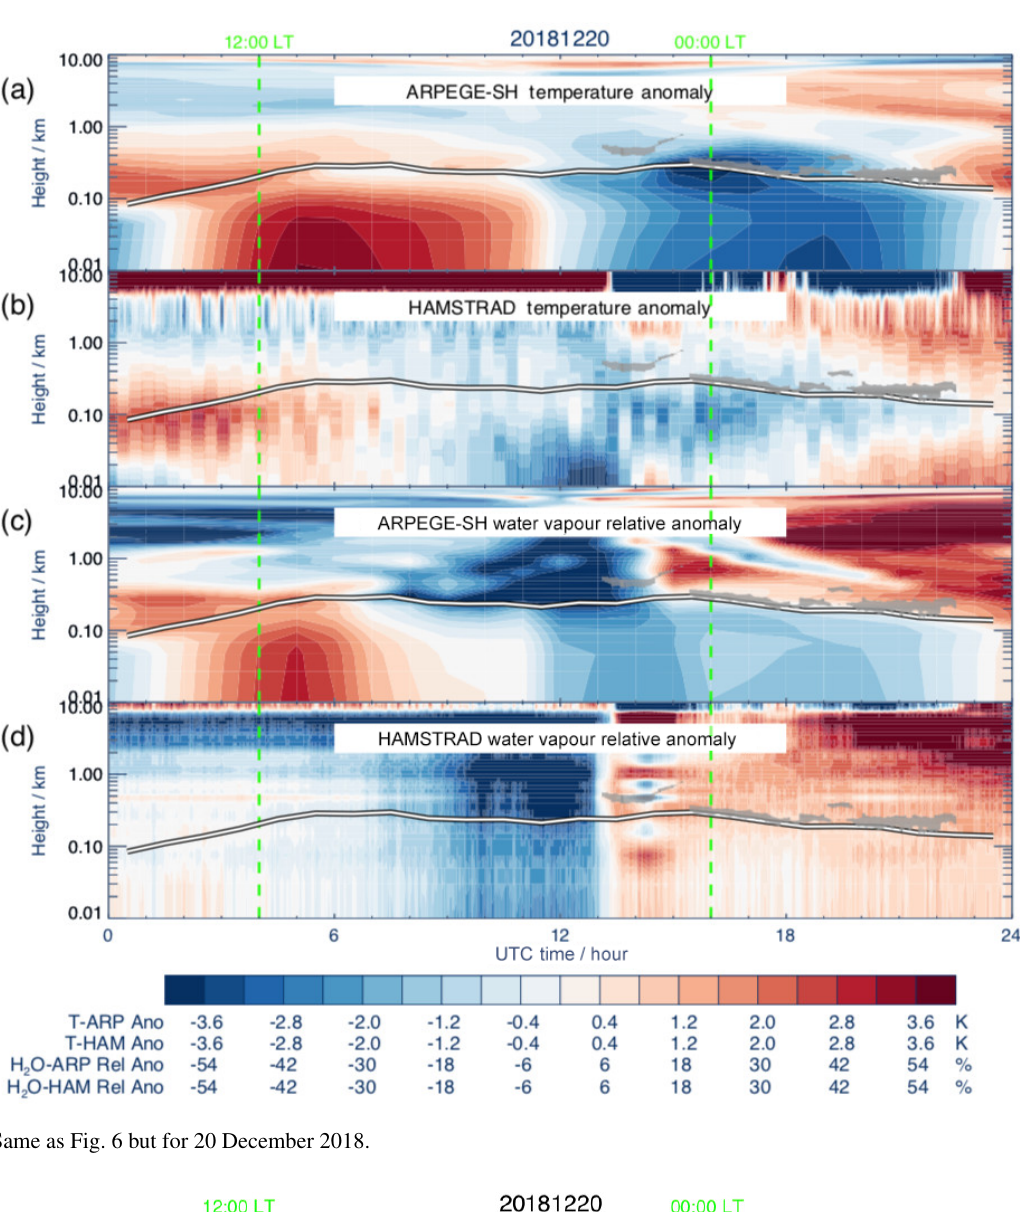
Figure 12. Same as Fig. 6 but for 20 December 2018.